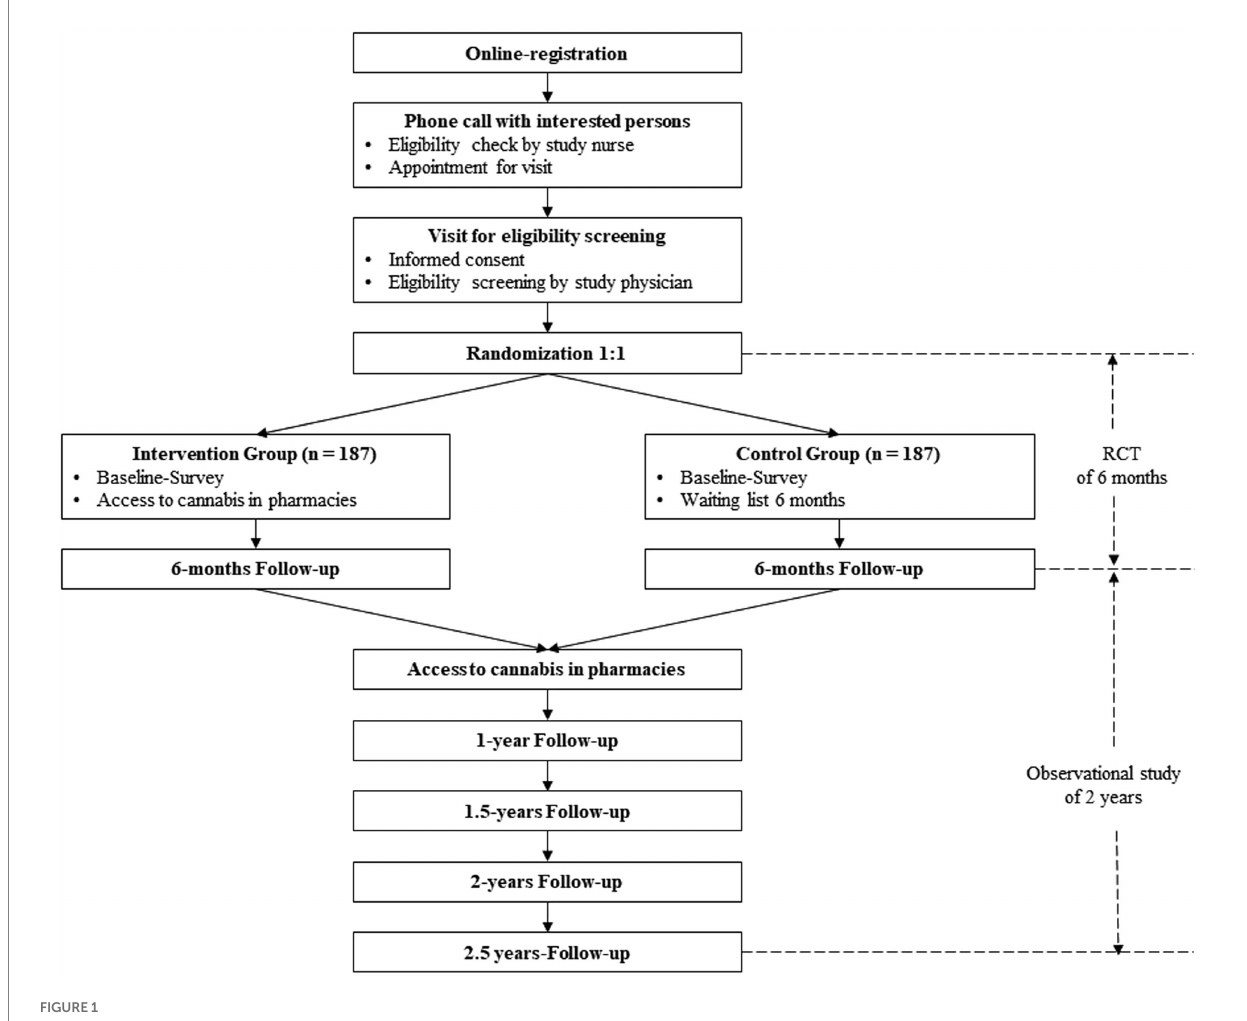
FIGURE 1 Flowchart of the